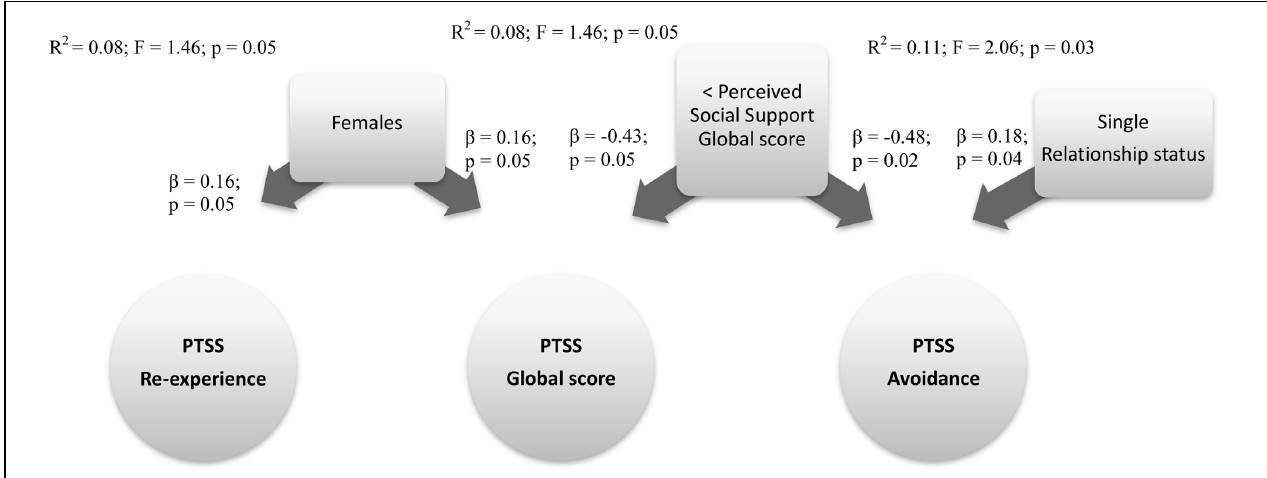
FIGURE 2 | Predictive factors of PTSS global score, PTSS re-experience, and avoidance criterions. Rectangle: stable Independent variables; Square: modifiable Independent variables; Circle: Dependent variables.